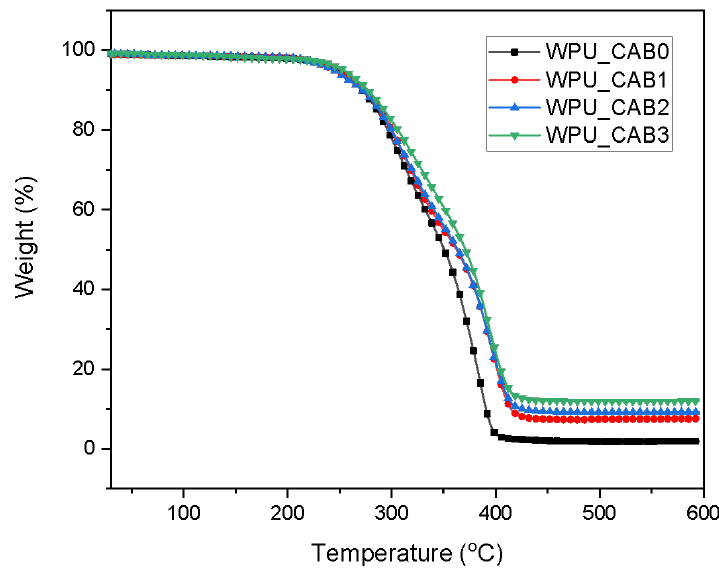
Figure 5. TGA curves of WPU films with different CAB contents.